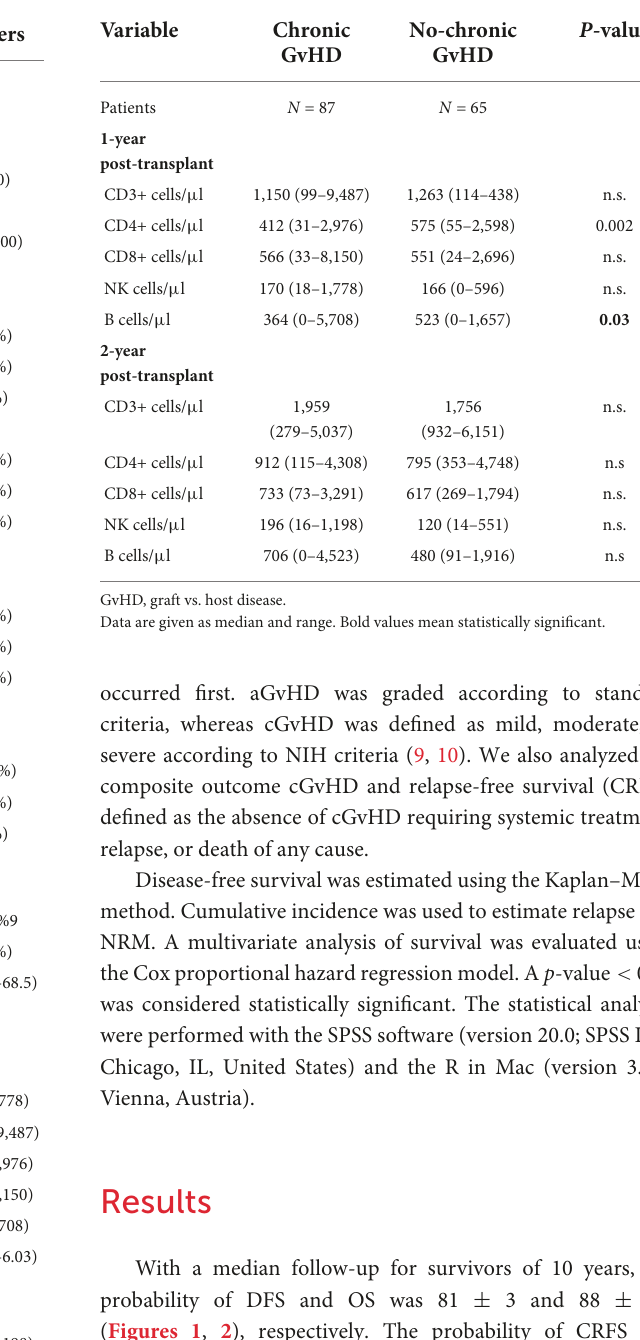
TABLE 1 Patient, donor, and transplant